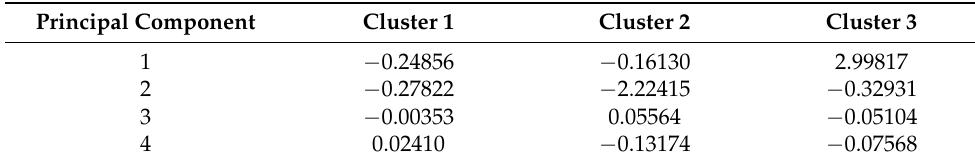
Table 5. Final cluster centers from k -means cluster analysis.